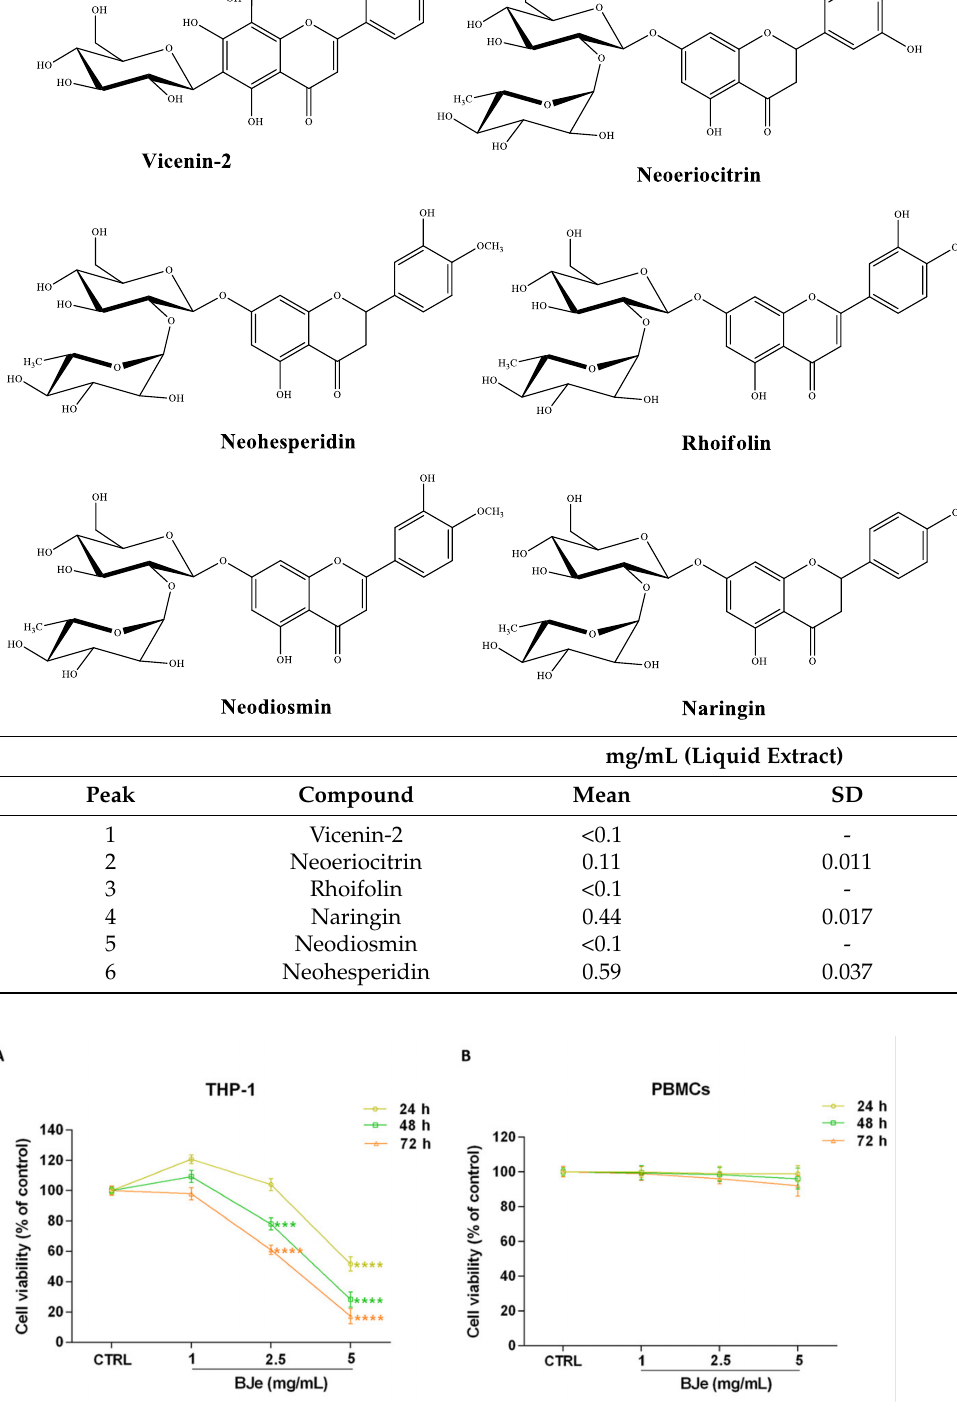
Figure 2. Effect on cell proliferation of BJe in THP-1 cells and PBMCs. Both cell lines were exposed to different concentrations of BJe (1–5 mg/mL) for 24, 48 and 72 h. Cell viability rate was assessed by MTT test ( A , B ). Results are expressed as percentages ± SEM of absorbance compared to values detected in the untreated cells (control, CTRL). Each concentration was tested eight-fold, and three independent experiments were carried out ( n = 24). *** p < 0.001 and **** p < 0.0001 vs.